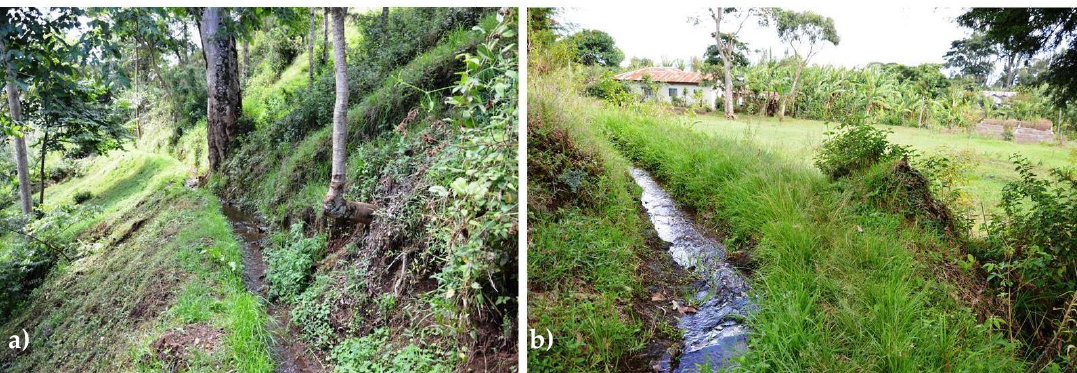
Figure 2. ( a ) a traditional water furrow ( mfongo ) cutting across a hillside on Mount Kilimanjaro; ( b ) a water furrow leading up to a Chagga home garden (photos published by Sunday [114] and reproduced with his permission @ Sabbath Sunday).